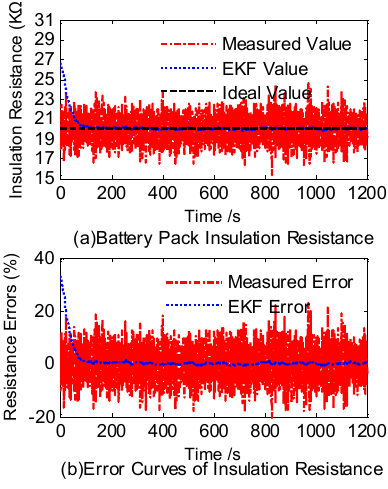
Figure 13. Comparison and error analysis of insulation resistances (with 20 K Ω resistance). ( a ) Comparison of insulation resistances; ( b ) Error analysis of insulation resistances.